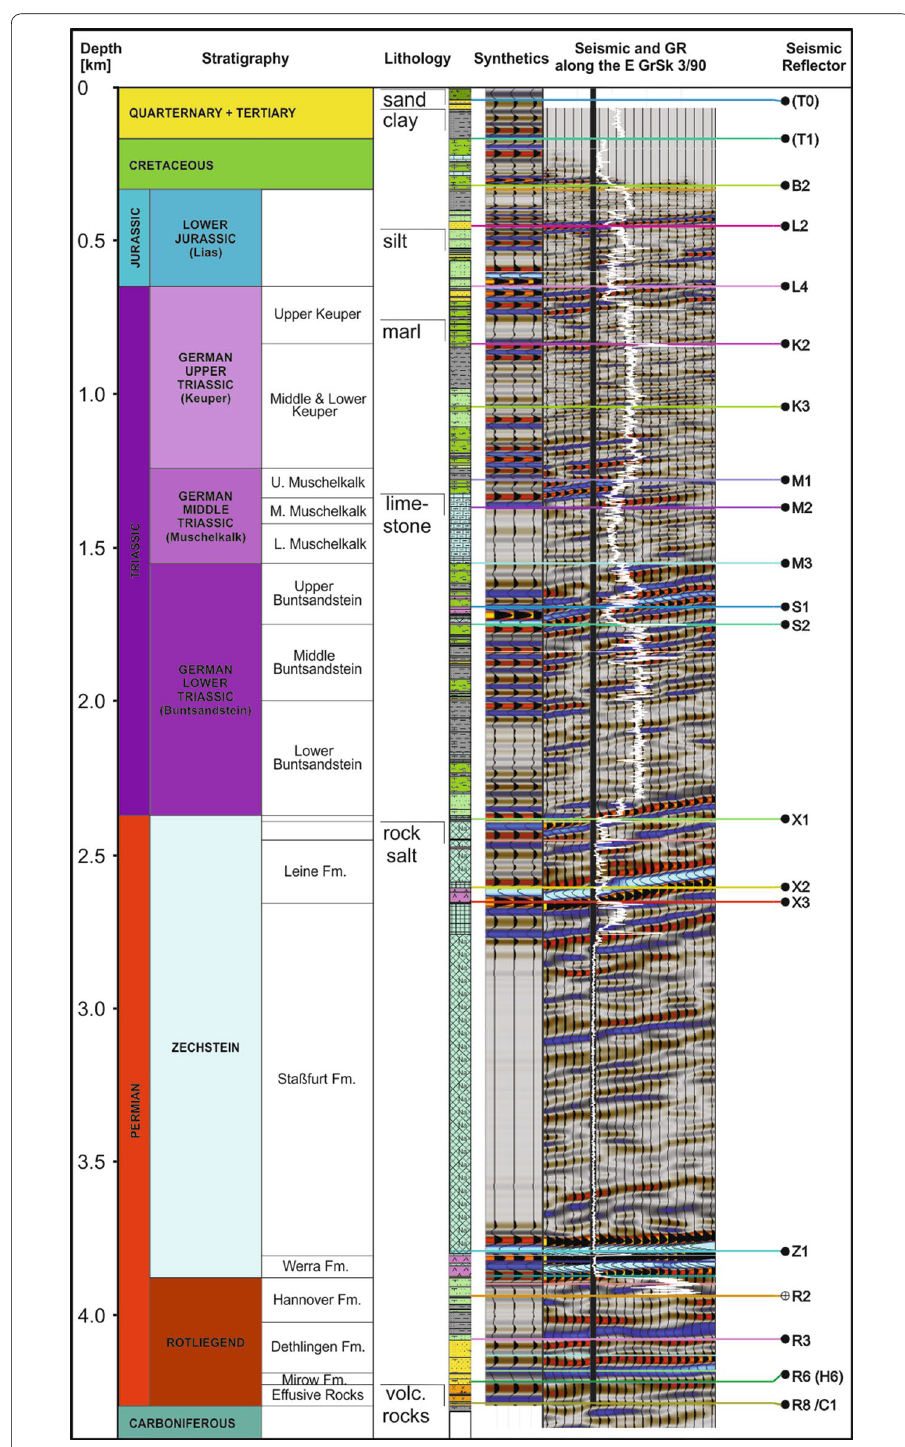
Fig. 2 Stratigraphy of borehole GrSk 3/90 (supplemented and revised from Moeck et al. 2009). Located in the centre of the 8 8 km survey area, it yields the lithology of the region. According to the Southern Permian × Basin nomenclature (after Reinhardt 1993), we define standard reflector names that will be further used for labeling in subsequent figures. These reflectors are verified together with the borehole Gamma log (white curve overlay, 0–150 API range) and synthetic seismic